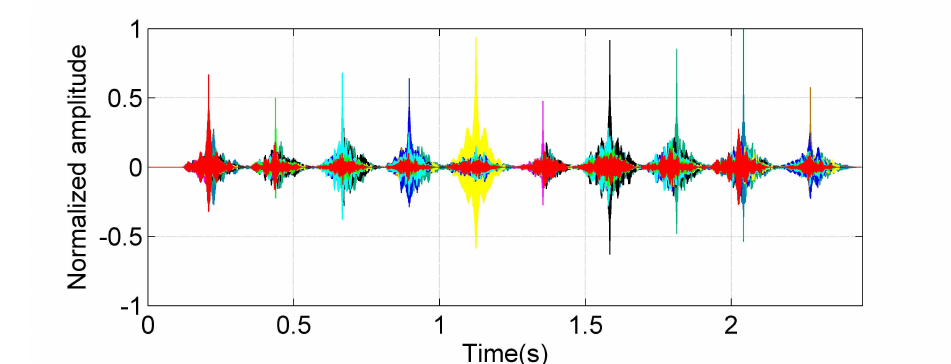
Figure 11. Correlation output of clicks.